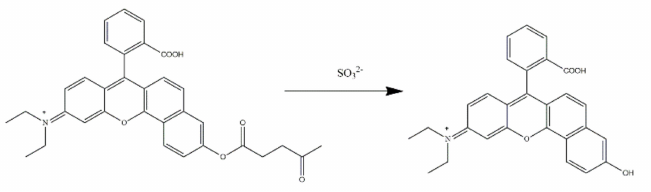
Figure 49. The possible reaction mechanism of the prepared sensor (Table 3, No. 12) for SO 32 − [101].